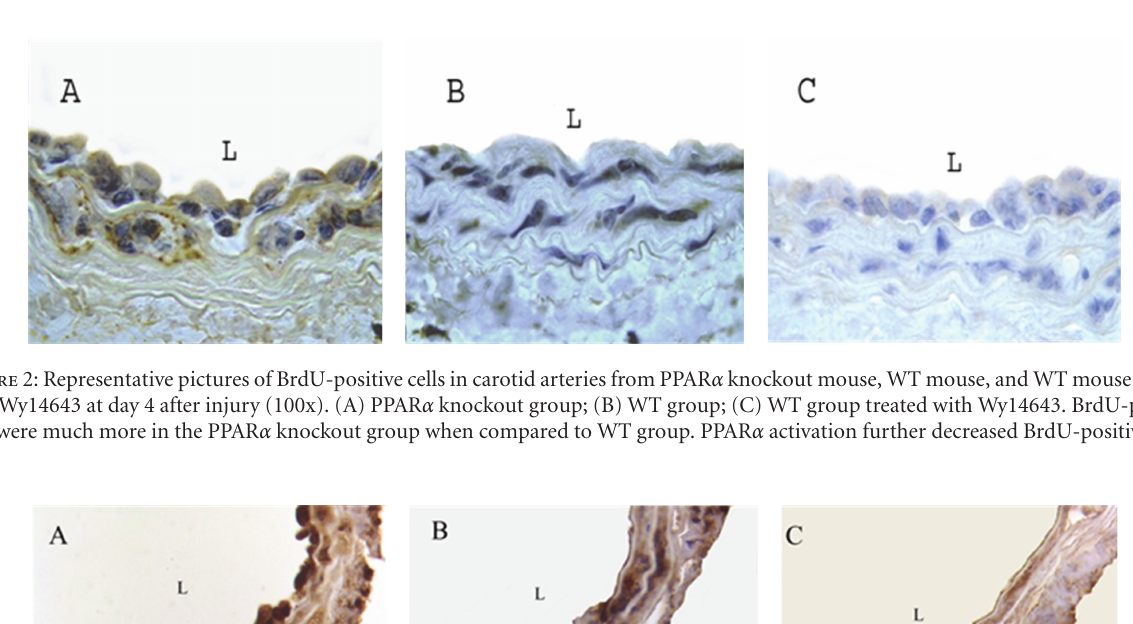
Figure 1: Photomicrographs of mice carotid arteries 21 days after injury (elastic staining, 63X). (A) representative cross-section of injured artery from PPAR α knockout mouse; (B) representative cross-section of injured artery from PPAR α knockout mouse treated with Wy14643; (C) representative cross-section of injured artery from WT mouse; (D) representative cross-section of injured artery from WT mouse treated with Wy14643.